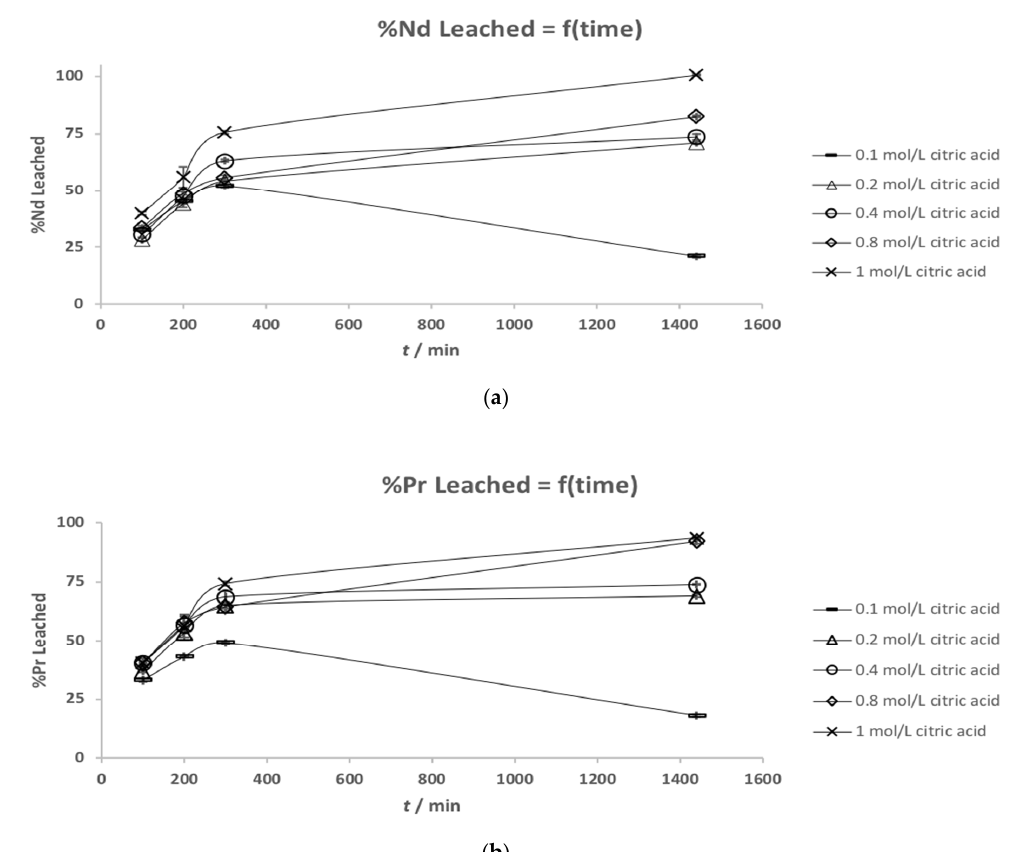
Figure 3. Effect of the concentration of acetic acid (0.1, 0.2, 0.4, 0.8 and 1 mol/L ) and leaching